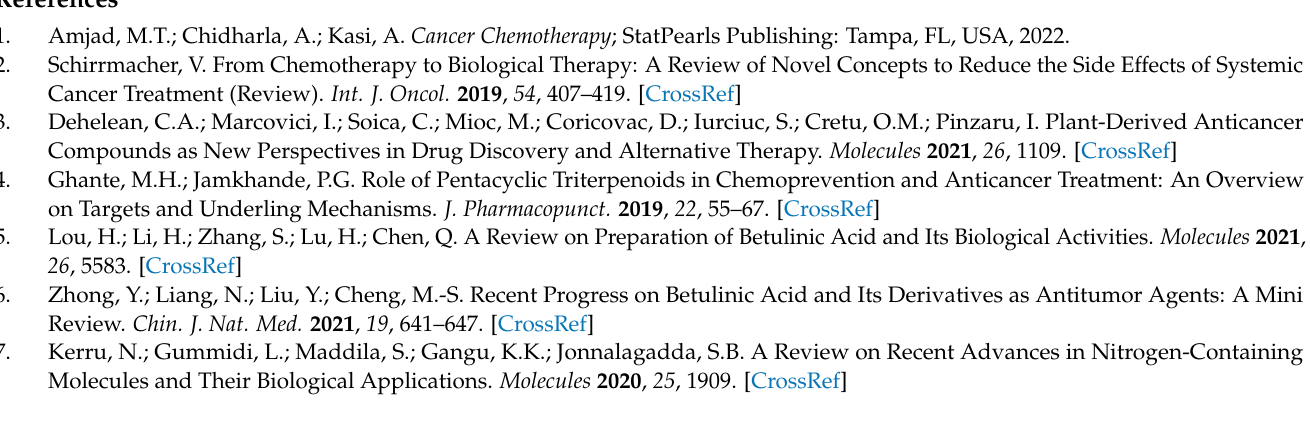
Figure S2: 13C NMR spectra of compound 2; Figure S3: 1H NMR spectra of compound 3a; Figure S4: 13C NMR spectra of compound 3a; Figure S5: 1H NMR spectra of compound 3b; Figure S6: 13C NMR spectra of compound 3b; Figure S7: 1H NMR spectra of compound 4a; Figure S8: 13C NMR spectra of compound 4a; Figure S9: 1H NMR spectra of compound 4b; Figure S10: 13C NMR spectra of compound